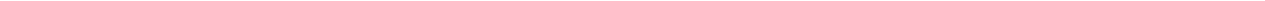
Fig. 1 Loss of dSms recapitulates polyamine imbalance of SRS and causes survival defects in Drosophila . a Diagram of human SMS gene structure and wild- type/mutant cDNA constructs. Fourteen mutations identi fi ed in SRS are indicated. The asterisks indicate new mutations. b Diagram of Drosophila CG4300 gene structure, predicated mRNA transcripts, and cDNA construct. dSms e allele has a P element inserted in the opposite direction of the gene (triangle). Capped line under mRNAs indicates qPCR probe. c Homology of SMS proteins across species scored by amino acid identity and similarity. Protein sequence (coded by gray region indicated in a and b ) alignment showing evolutionary conservation (gray background). Arrowheads indicate amino acids affected in SRS. d qPCR of dSms normalized to Rp49 in control, dSms e/ + , and dSms e/e fl y heads (mean ± S.E.M.; n = 4 extractions, each extraction from 10 fl y heads). e Scatter dot plot of viability index (mean ± 95% CI, n = 14 for dSms e/e , 12 for dSms RA rescue, 11 for hSms wt rescue, and 13 for hSms 443 rescue; each data point represents a sample of ≥ 80 embryos) of control, dSms e/e , and dSms e/e fl ies ubiquitously expressing cDNA constructs. f Diagram of polyamine metabolic pathway (Put putrescine, Spd spermidine, Spm spermine, SPDSY spermidine synthase, N 1 -AcSpd N 1 -acetylspermidine, PAO polyamine oxidase, SSAT spermidine/spermine acetyltransferase, 3-AAP 3-acetoamidopropanal). g Absolute levels (mean ± 95% CI, n = 9/7 for male control/ dSms e/e and 9/9 for female control/ dSms e/e spermidine levels; n = 8/7 for male control/ dSms e/e and 9/9 for female control/ dSms e/e putrescine levels; each data point represents a sample of ≥ 20 fl ies) of polyamines in the whole body of young (2 – 5 DAE) fl ies measured by LC-MS/MS. h Climbing performance (mean ± S.E.M.; each data point obtained from a group of 10 individuals, n = 10 experiments) of male and female fl ies at 2 DAE. i Fly survival curves ( n = 109/106 for control male/female, 75/62 for dSms e/e male/female, and 130/132 for dSms e/e ; actin > dSms RA male/female fl ies) determined by the